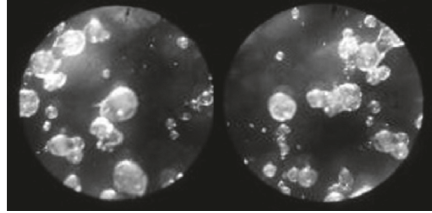
Figure 6: Shape of the artificial snow particles. Table 2: Comparison of physical parameters of snow particles.